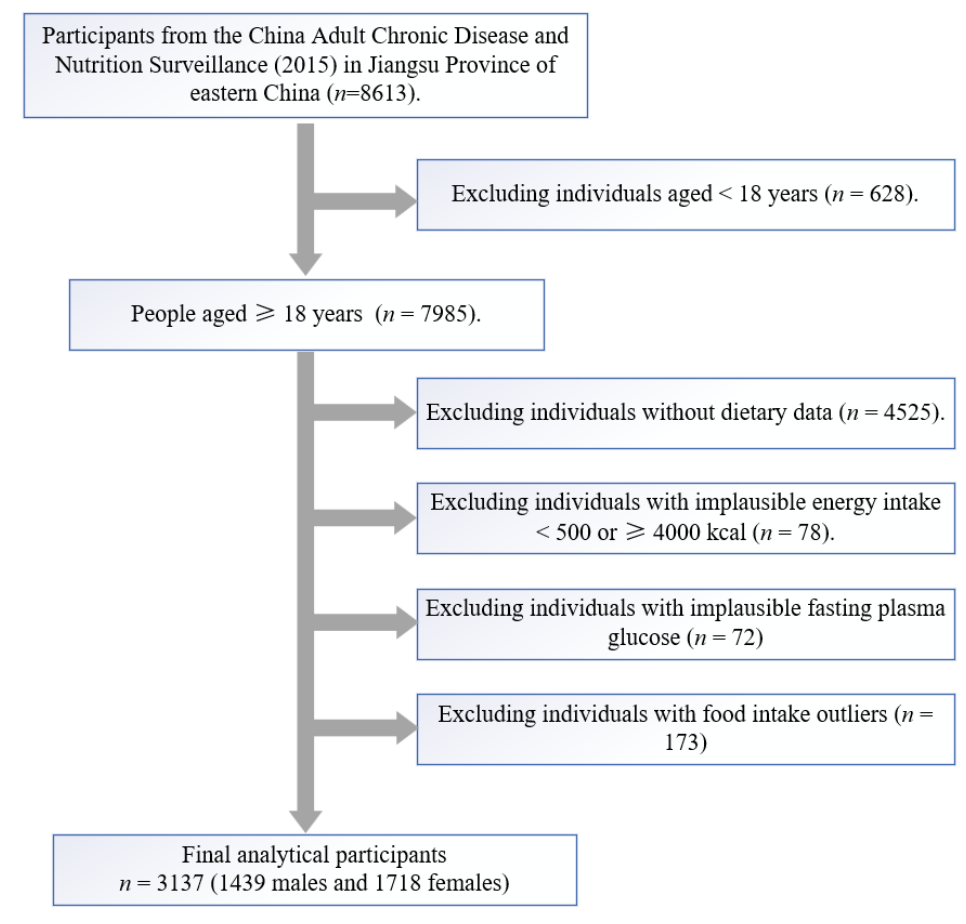
Figure 1. Flow chart of participants included in the study.